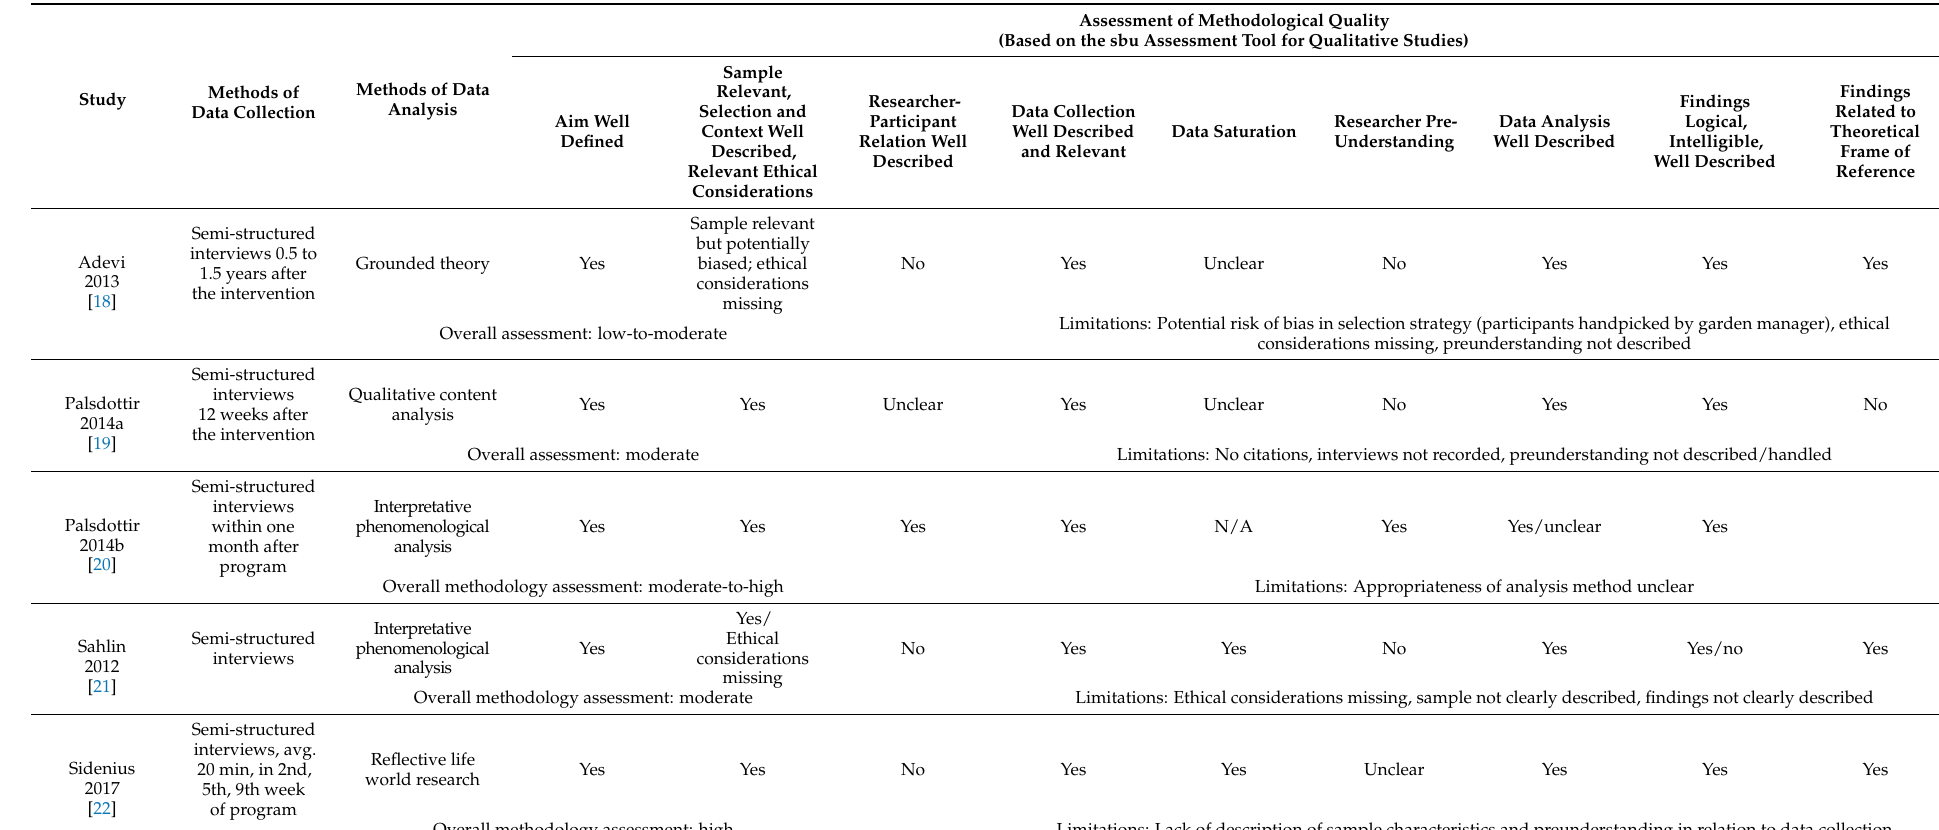
Table 2. Assessment of methodological quality of the included